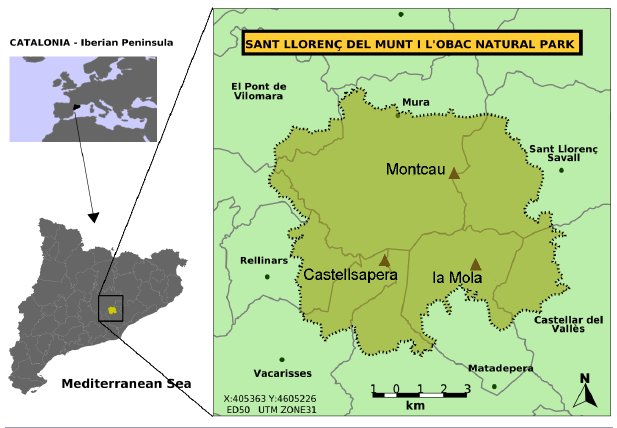
Fig. 1 . Map of the study